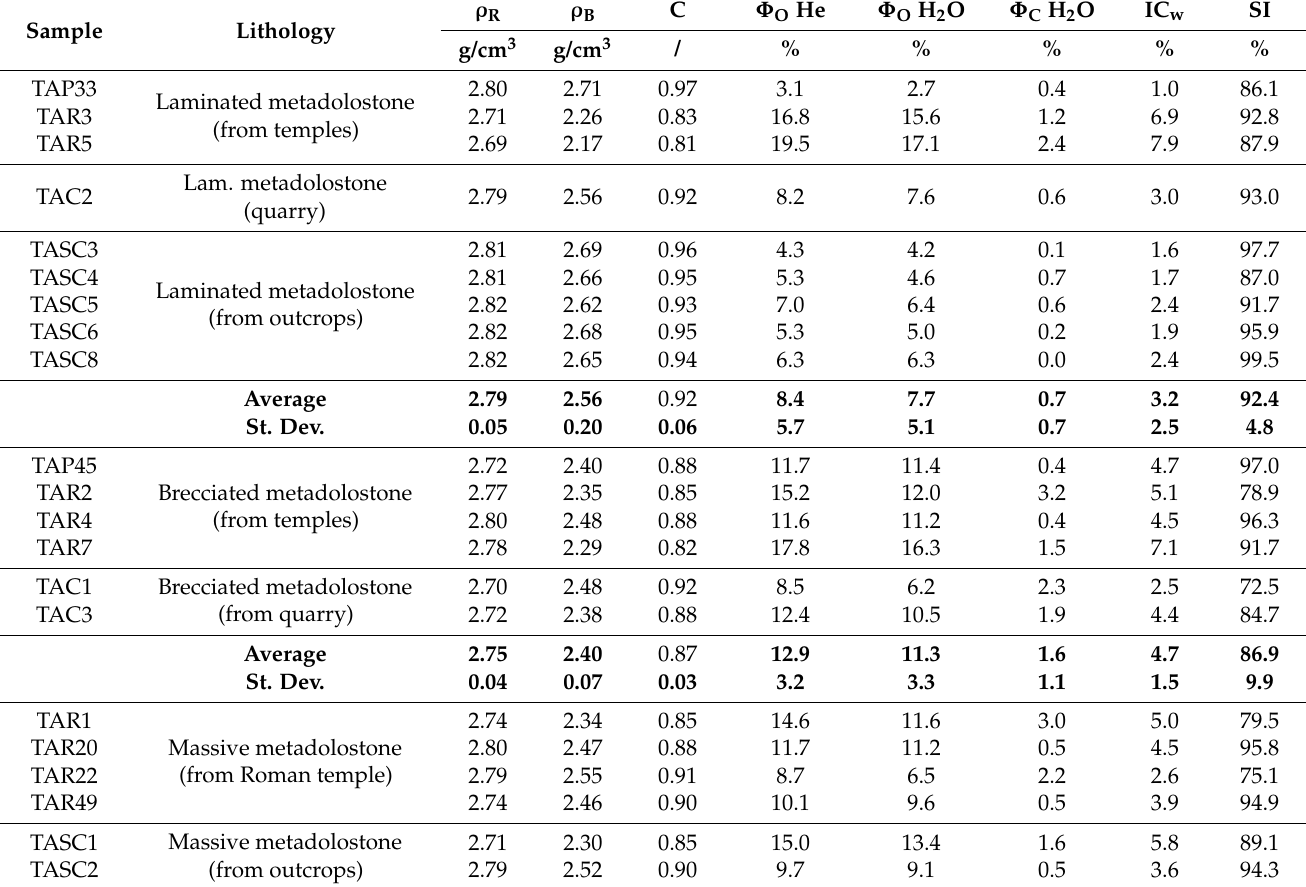
Table 2. Main following physical properties (real ( ρ R ) and bulk ( ρ B ) density, compact index (C), helium ( Φ H 2 O) and water ( Φ He) open porosity, water closed porosity ( Φ C H 2 O), weight imbibition coefficient (IC W ), water saturation index (SI)) of samples studied from the Punic and Roman temples of Antas and from outcrops.